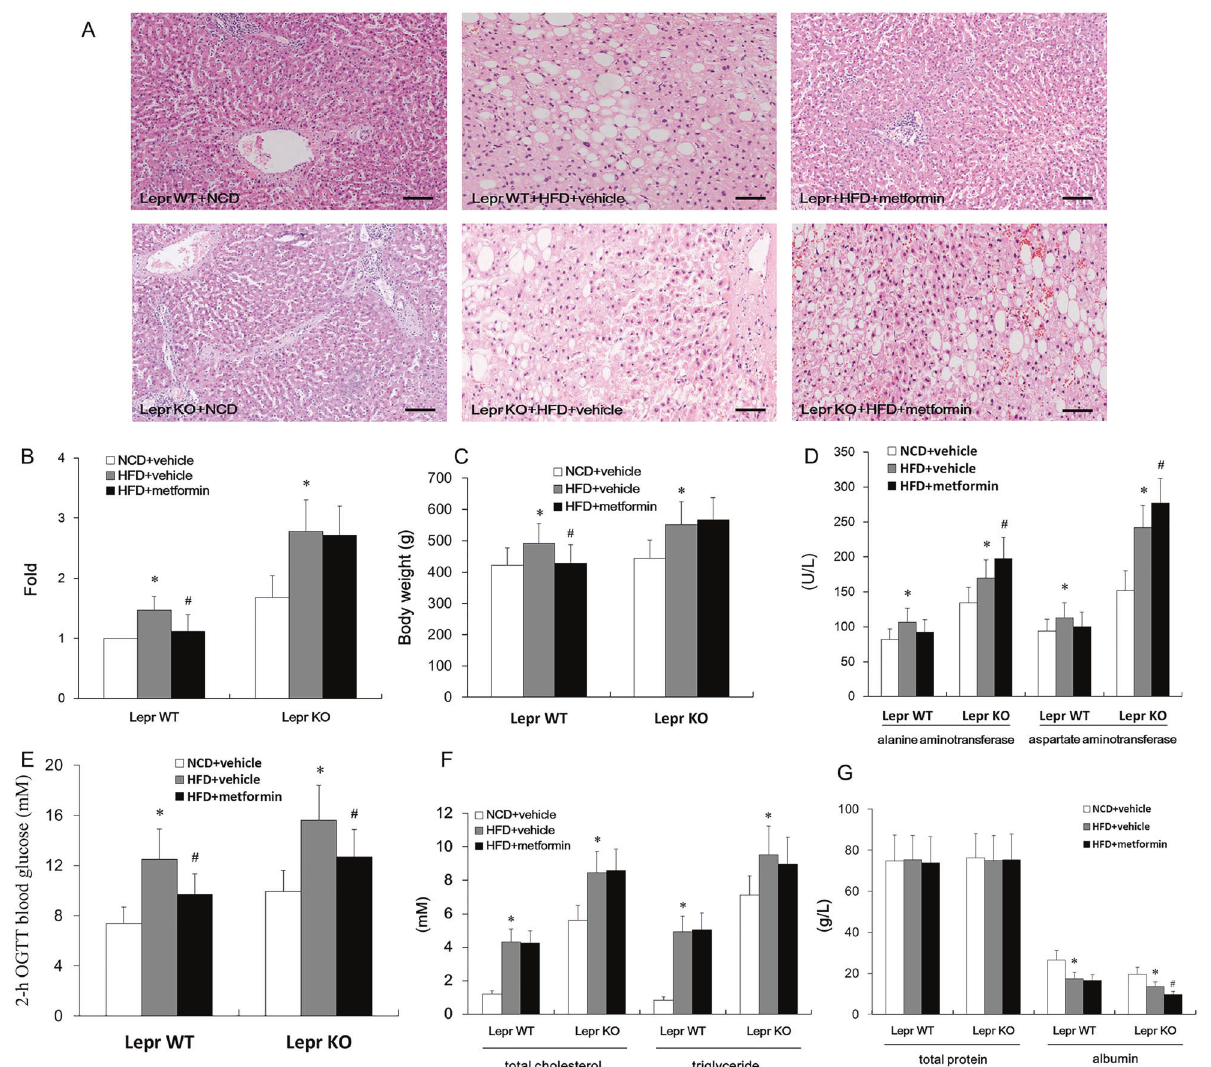
C Body weight. n = 12. D Quantitation of alanine aminotransferase (ALT) and aspartate aminotransferase (AST) in serum. n = 12. E Quantitation of 2-h OGTT blood glucose. n = 12. F Detection of blood total cholesterol and triglycerides. n = 12. G Quantitation of total protein and albumin in the peripheral blood. n = 12. * p < 0.05 vs. NCD + vehicle; # p < 0.05 vs. HFD +